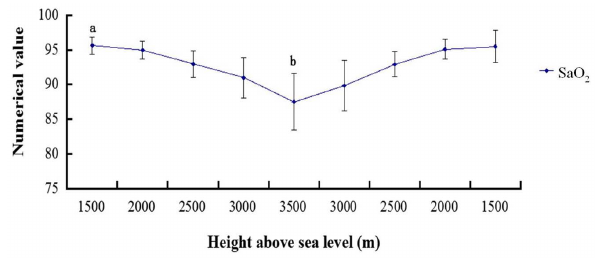
Figure 1. Graph showing the SaO 2 during the ascent and descent phases. a P , 0.01: compared with the altitudes of 2500 m, 3000 m, and 3500 m; b P , 0.01: compared with the altitudes of 3000 m, 2500 m, 2000 m, and 1500 m.